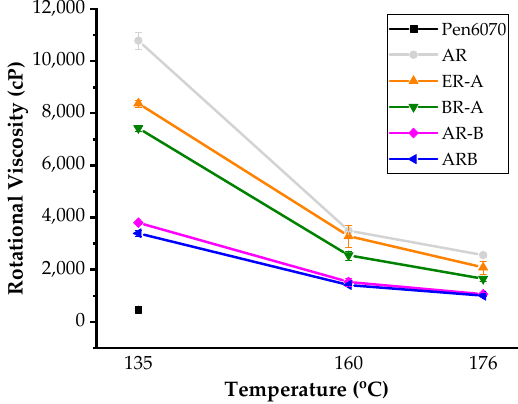
Figure 2. Rotational viscosity test results.